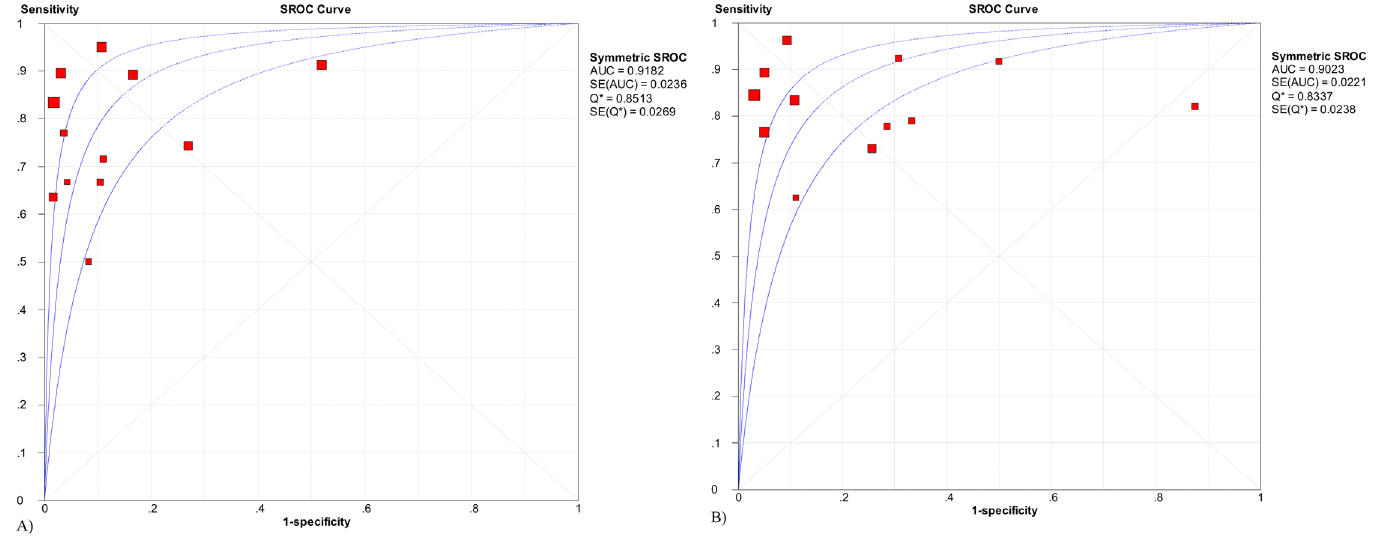
Fig 4. SROC curve of sub-staging for early disease. A) SROC curve for T1a; B) SROC curve for T1b.